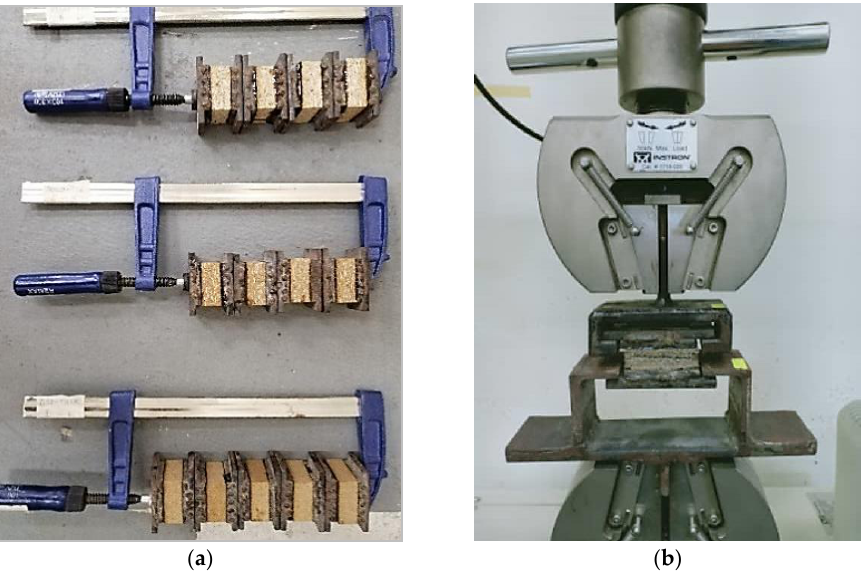
Figure 12. Tensile Strength Perpendicular to Plane of Board; ( a ) Test pieces glued to metal plate and dried for 24 h, ( b ) The arrangement of apparatus during laboratory testing.